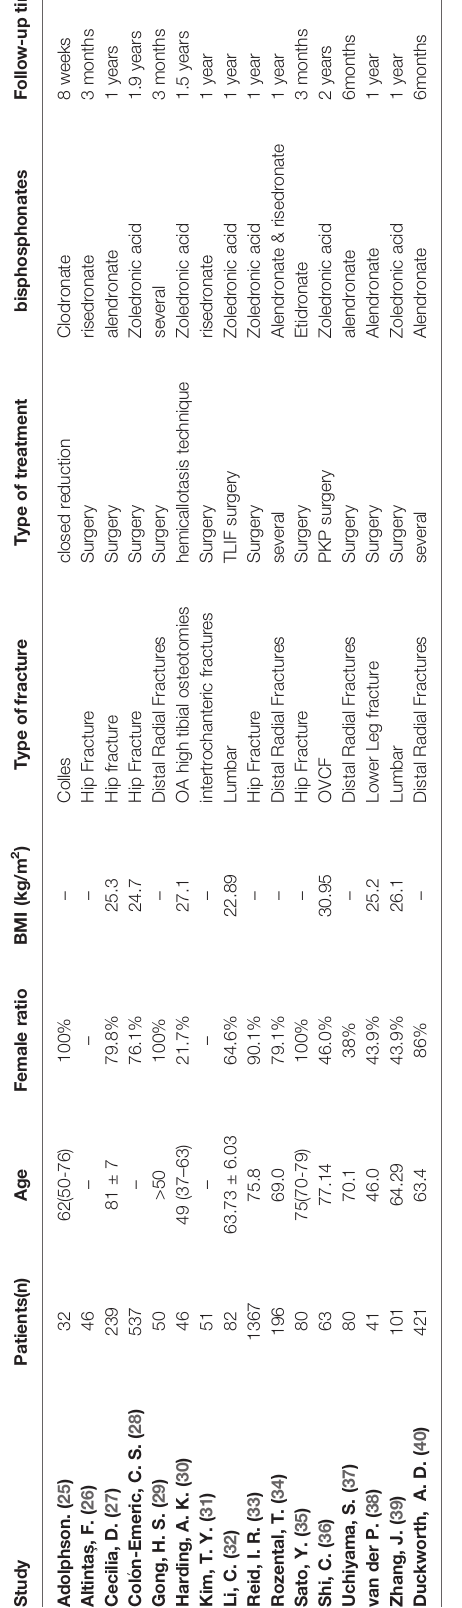
study from the analysis and determined pooled SMD. Signi fi cant change of I2 (98% ! 77%) and SMD (1.26 ! 0.84) occurred in BMD change Forest plot with Reid et al. (33) deleted. Results showed BPs increased bone density. In other words, while the sensitivity of the study may have been affected, the results did not change.